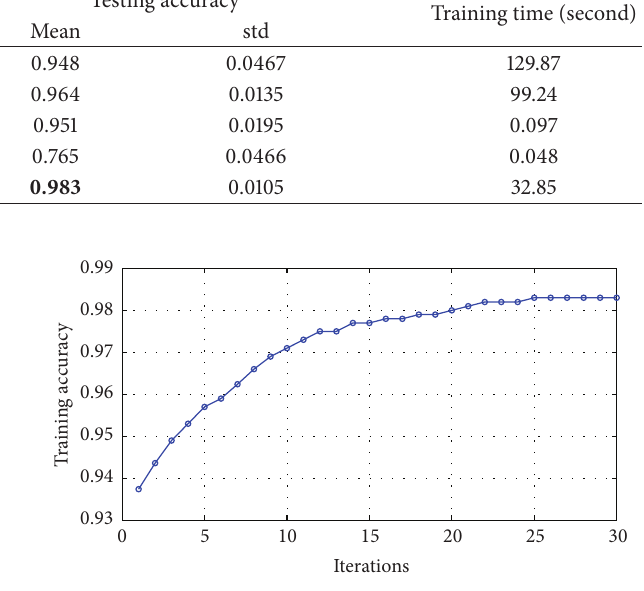
Figure 8: Mean evolution of the testing accuracy of our method.